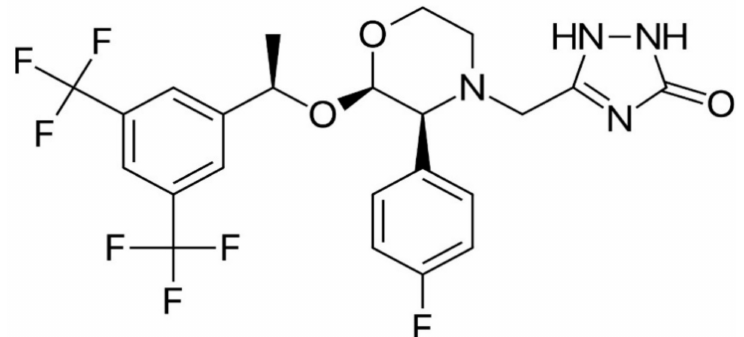
Figure 1. Chemical structure of